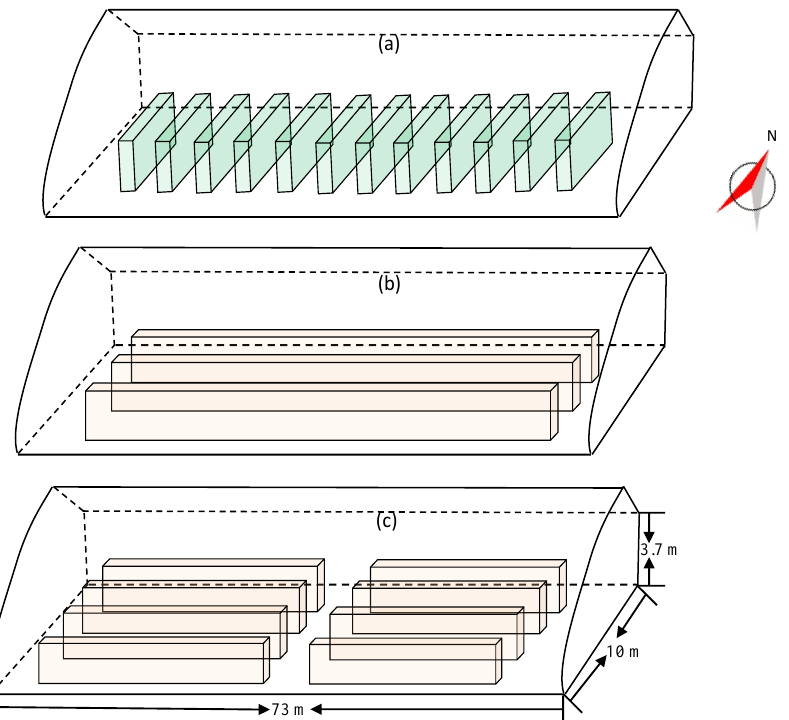
Figure 1. Comparison between traditional north-south cultivation ( a ) and east-west cultivation (( b , c ) with a central belt) in solar greenhouses, Northern China.